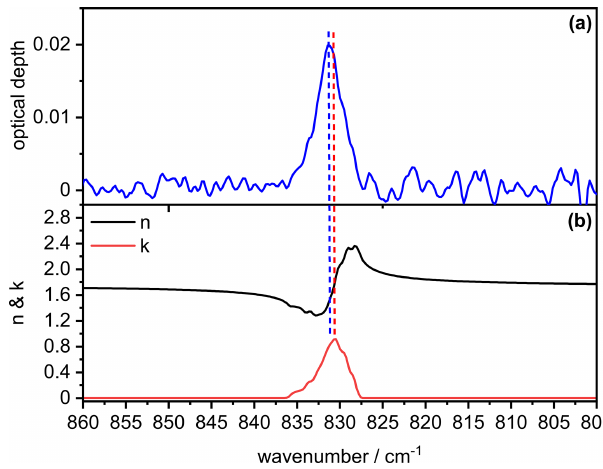
Figure B2. Comparison between the measured infrared extinction spectrum of crystalline AN particles (a) and the retrieved optical constants (b) in the 800–860cm − 1 wavenumber range. The re- trieval was performed with the parameters n( ˜ ν x ) = 1 . 56, χ = 1 . 1, and ϕ = 1. Vertical dashed lines indicate the peak position in the particle extinction spectrum (blue) and the k( ˜ ν) spectrum